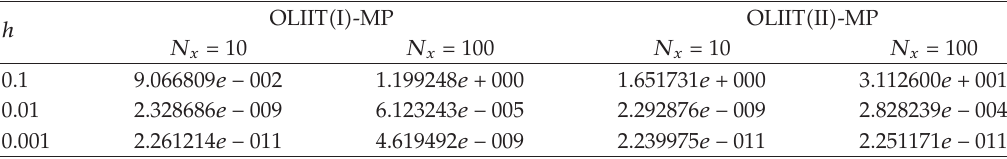
Table 7: The errors (cid:16) at t (cid:5) 10 when the algorithms are applied to the problem (cid:3) 5.6 (cid:4) with the coe ffi cients group III, where τ (cid:3) t (cid:4) (cid:5) sin t (cid:8) 1.